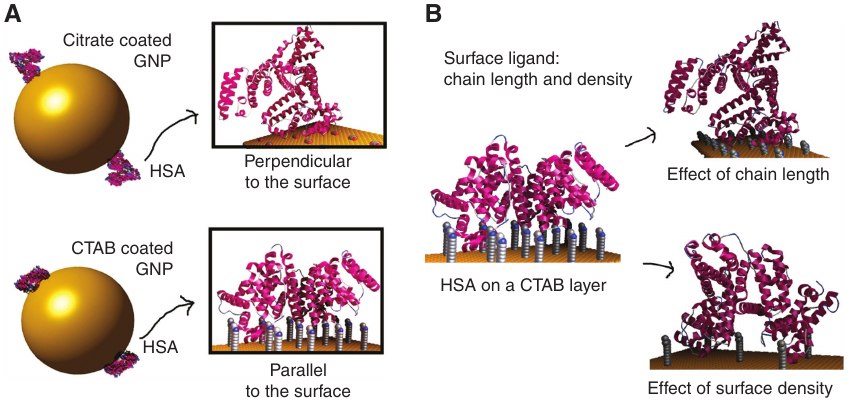
Figure 3 The effect of surface chemistry on the orientation and stability of an adsorbed protein. (A) On a citrate-coated gold NP, protein adsorption is very strong compared to a CTAB-coated particle. The orientations are also distinctly different as indicated in the diagram. (B) The chain length and the surface density of a particular surfactant molecule can greatly affect the process of protein adsorption on a NP